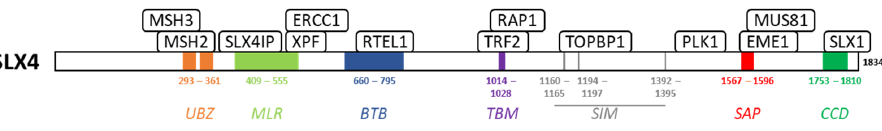
Figure 1. Schematic structure of SLX4 protein with different protein domains (in colors) and interact ‐ ing proteins. Adapted from [9]. BTB: Bric ‐ a ‐ brac, tramtrack, broad complex; CCD: Conserved C ‐ termi ‐ acting proteins. Adapted from [9]. BTB: Bric-a-brac, tramtrack, broad complex; CCD: Conserved nal Domain; MLR: MUS312 ‐ MEI9 interaction ‐ like region; SAP: SAF ‐ A/B, Acinus and PAIS; SIM: C-terminal Domain; MLR: MUS312-MEI9 interaction-like region; SAP: SAF-A/B, Acinus and PAIS; SUMO ‐ interacting motif; TBM: TRF2 ‐ binding motif; UBZ: ubiquitin ‐ binding zinc finger type 4. SIM: SUMO-interacting motif; TBM: TRF2-binding motif; UBZ: ubiquitin-binding zinc finger type